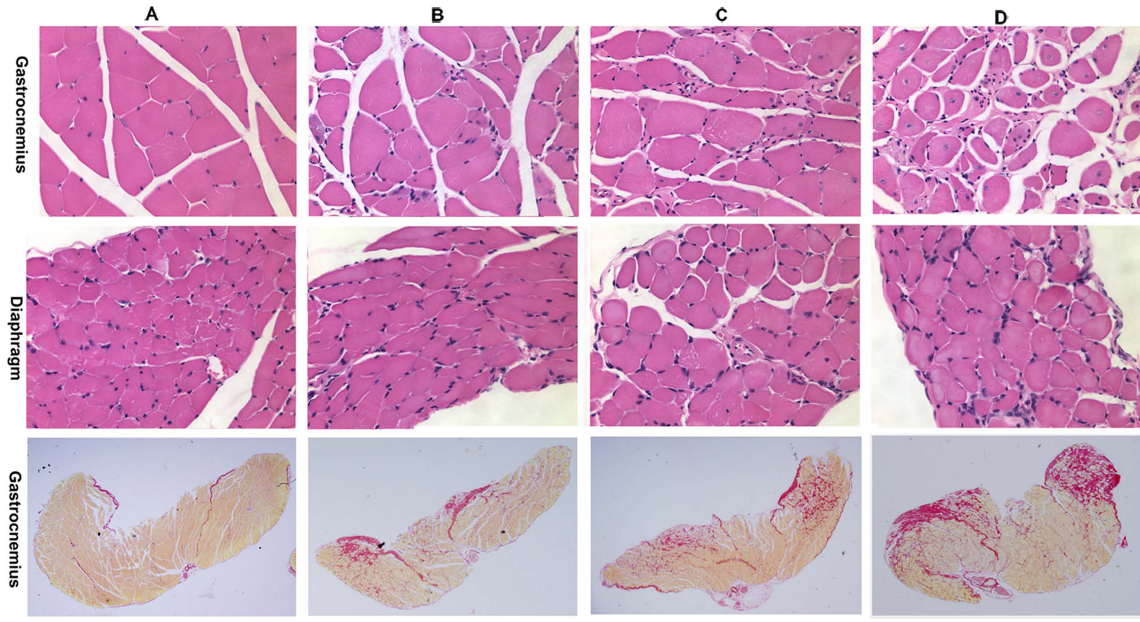
Figure 1. Histological analysis of gastrocnemius and diaphragm with H&E (top two rows) and gastrocnemius with picrosirius red (bottom row) show increased fibrosis and centralized nuclei in dy 2J mice. BL6 control mice are shown in column A. dy 2J mice treated with 0.1 mg/kg omigapil (Column B) showed markedly less fibrosis compared to dy 2J mice treated with 1 mg/kg omigapil (Column C) or vehicle (Column D).